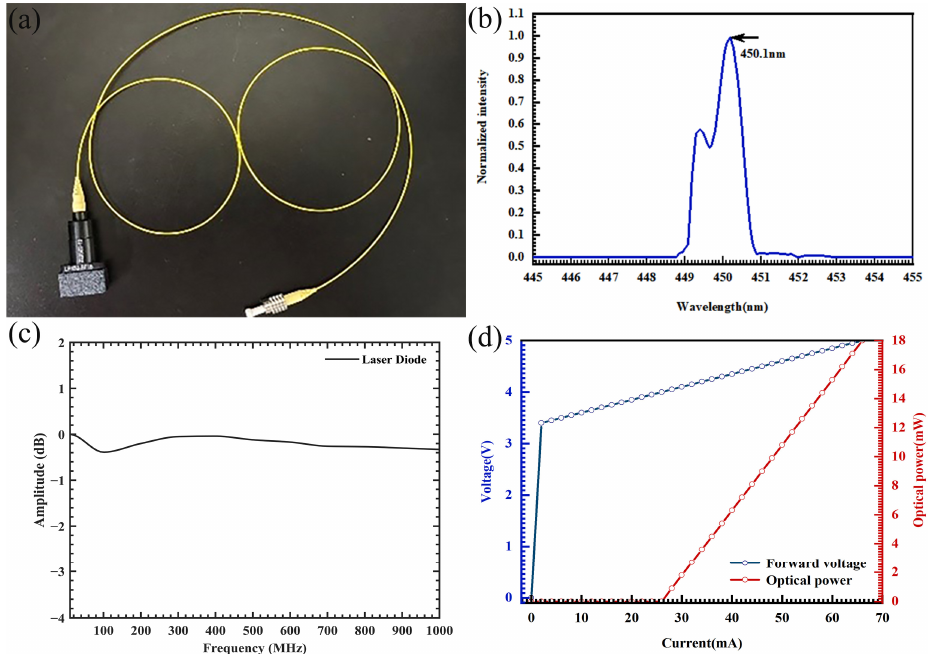
Figure 2. Transmitter blue LD: ( a ) single mode fiber-pigtailed LD, ( b ) the optical spectral property, ( c ) 3 dB bandwidth of LD, ( d ) VI and P–I curves when the operating temperature was 25 °C.